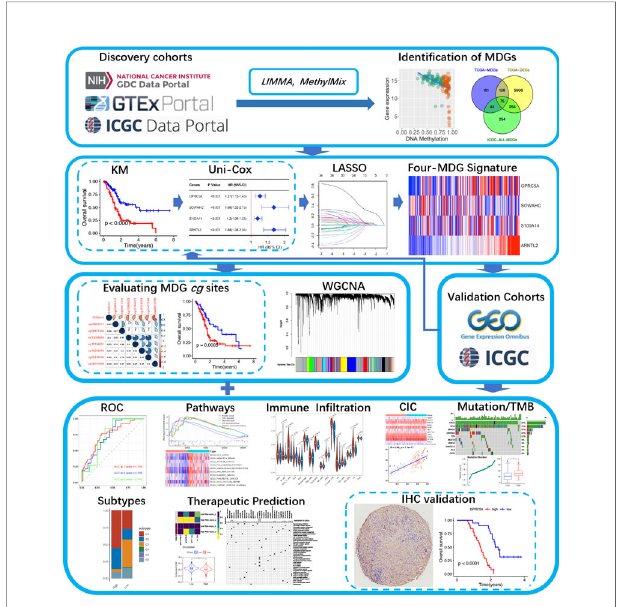
FIGURE 1 | A fl ow chart of the current